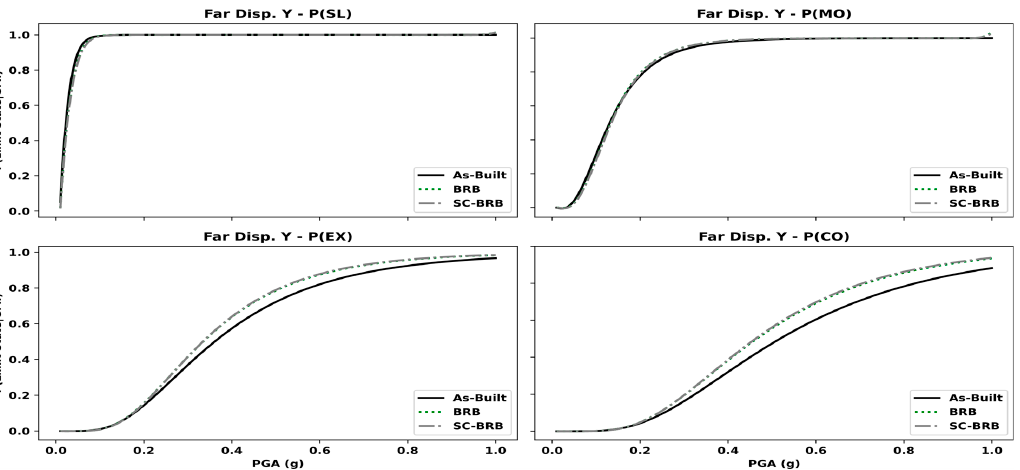
Figure 27. Fragility curves of BD demands under far-field records in the transverse direction (as-built vs. retrofitted bridges with different BRB techniques).